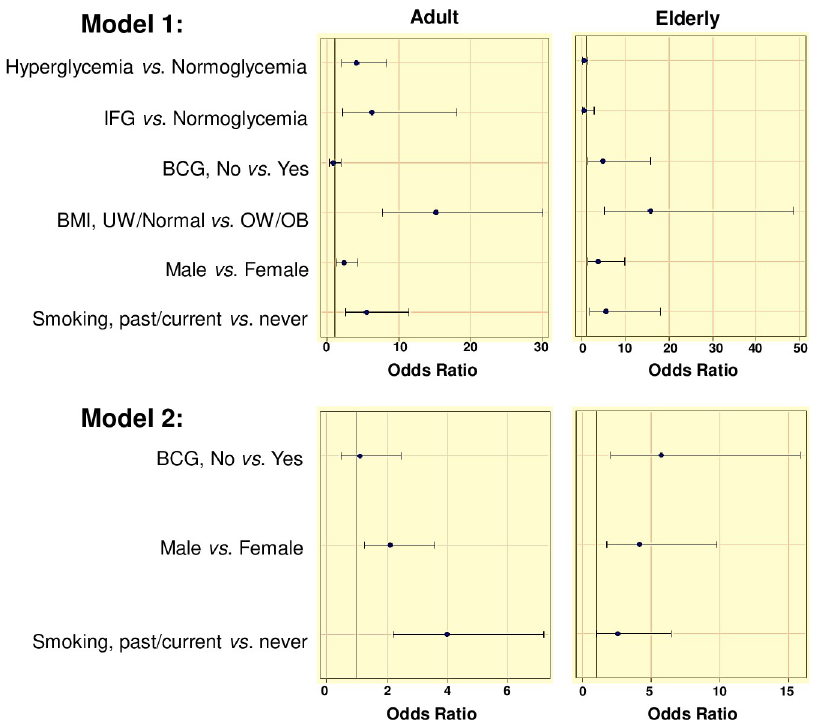
Fig 3. Multivariable logistic regression models of odds of TB vs non-TB among adults or elderly, for different host characteristics. Host characteristics with a p value � 0.09 by univariable analysis were selected as indicated in the text for model 1. For model 2, BMI and glycemia were removed from model 2, given that they may be modified once TB develops. Graphs show odds ratio with Wald 95% CI. Abbreviations: IFG, impaired fasting glucose; UW, underweight (BMI < 18.5); OW/OB, overweight/obese (BMI > 25); BMI, body-mass index; BCG, Bacillus Calmette- Gue´rin vaccinated.